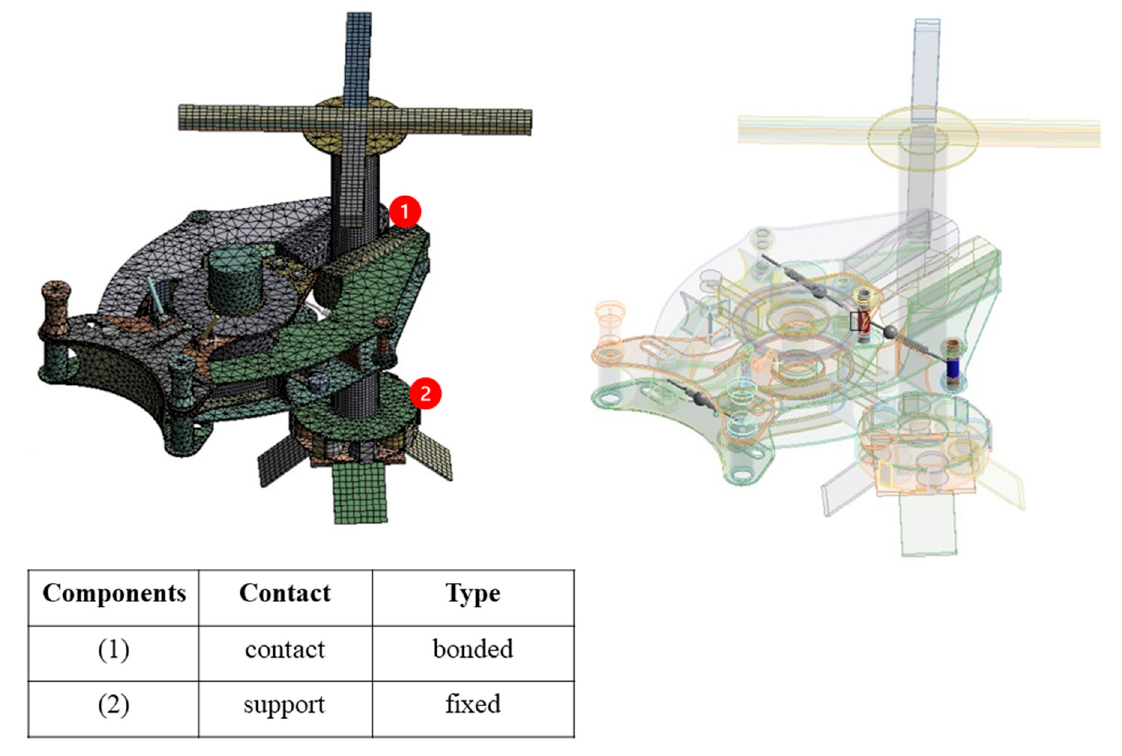
Figure 5. Meshing ( left ) and ‘Connections’ ( right ) defined in the simplified model of the trunk shaker and test bench.